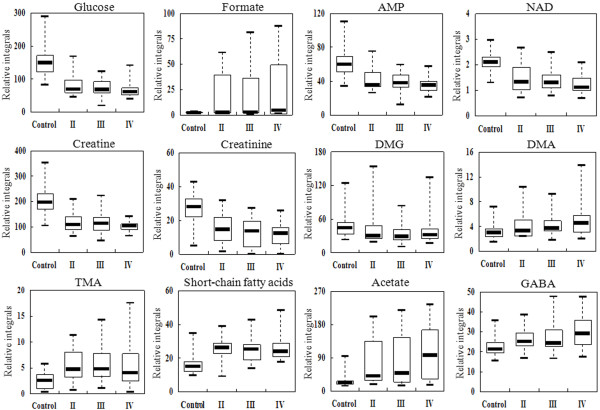
Box-and-whisker plots illustrated progressive changes of the metabolites among different stages of esophageal cancer relative to normal mucosae. Horizontal line in the middle portion of the box, median; bottom and top boundaries of boxes, lower and upper quartile; whiskers, 5th and 95th percentiles; open circles, outliers.